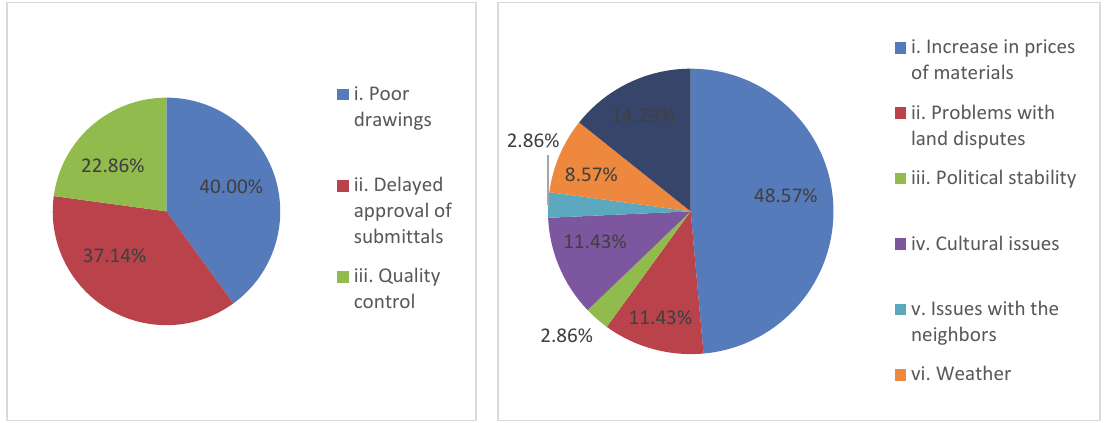
Fig. 7. Consultant related causes of pro- Fig. 8. External factors influencing on project ject delays